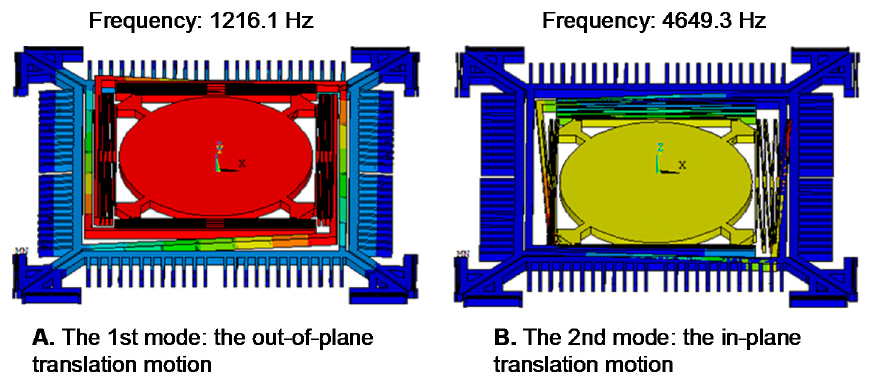
Figure 3. Finite element method (FEM) modal analysis. ( A ) The first mode (1216 Hz): the desired out-of-plane translational motion; ( B ) the second mode (4649.3 Hz): the in-plane translation motion.